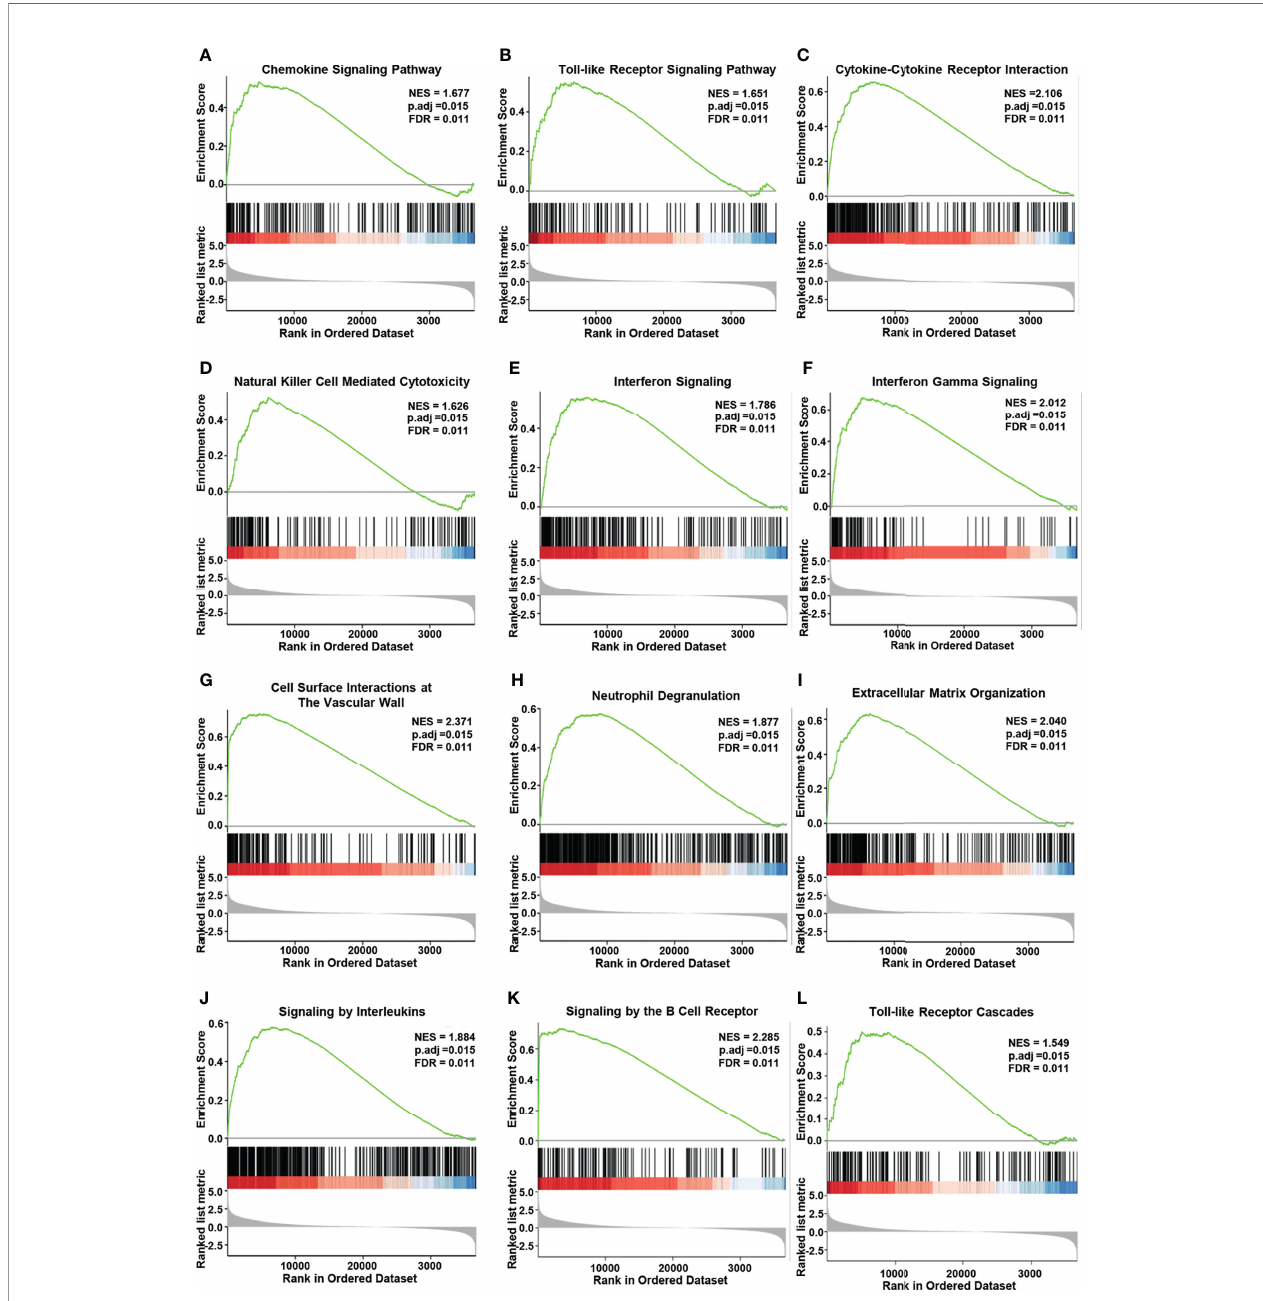
FIGURE 5 | Enrichment plots from Gene Set Enrichment Analysis (GSEA). MK3 upregulation was signi fi cantly correlated with “ chemokine signaling ” (A) , “ Toll-like receptor signaling ” (B) , “ cytokine – cytokine receptor interaction ” (C) , “ natural killer cell-mediated cytotoxicity ” (D) , “ interferon signaling ” (E) , “ interferon-gamma signaling ” (F) , “ cell surface interactions at the vascular wall ” (G) , “ neutrophil degranulation ” (H) , “ extracellular matrix organization ” (I) , “ signaling by interleukins ” (J) , “ signaling by the B-cell receptor ” (K) , and “ Toll-like receptor cascades ” pathways (L) . Data used for GSEA was obtained from TCGA. GO, Gene Ontology; KEGG, Kyoto Encyclopedia of Genes and Genome; TCGA, The Cancer Genome Atlas; GSEA, Gene Set Enrichment